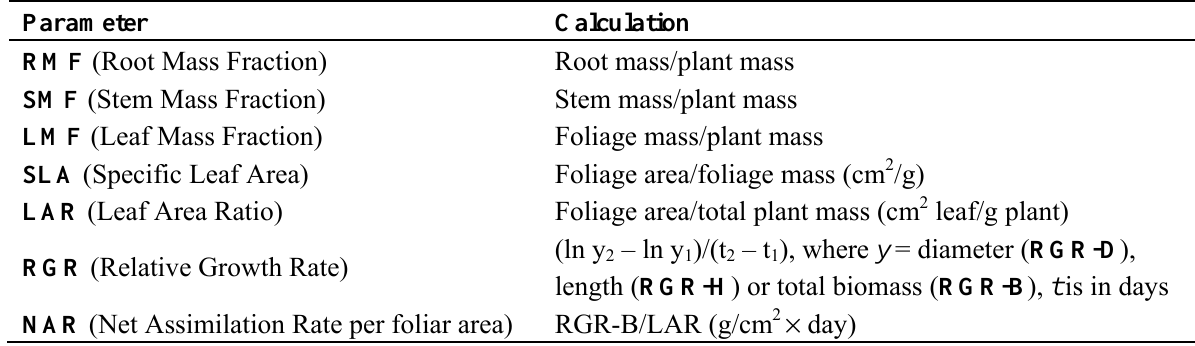
Table 1. Acer platanoides and A. saccharum seedling growth and morphological